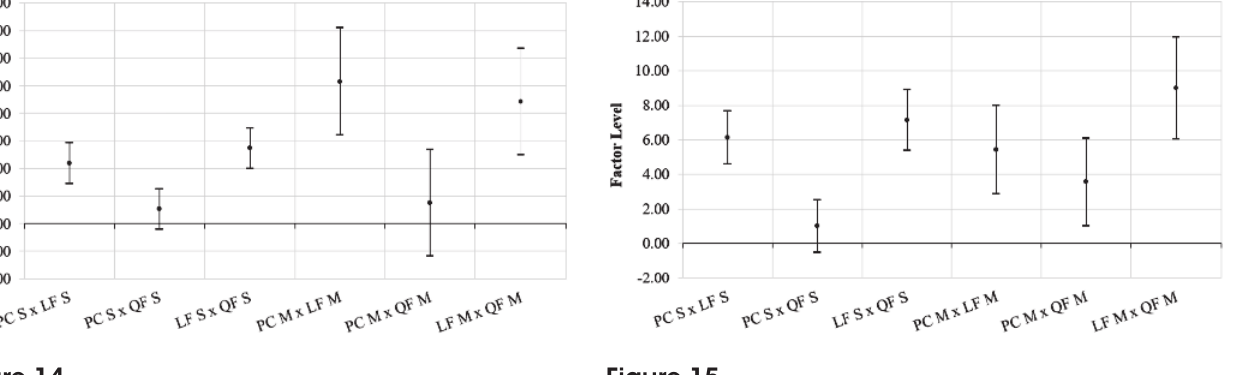
Comparison between averages of compressive strength losses (tukey test for a significance level of 5%) of the same series for different aggressive solutions (S - sodium sulfate and M - magnesium sulfate) for 20 weeks of